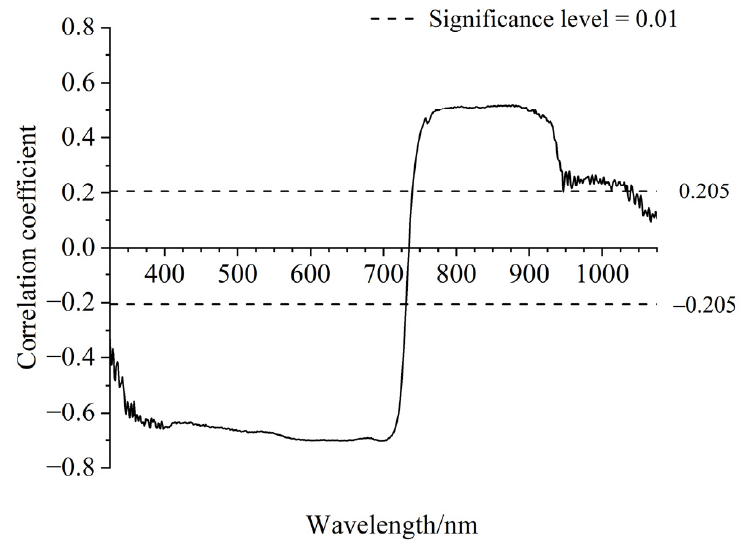
Figure 3. Correlation coefficients between reflectance and LAI (min/max, 0.34/5.56).3.3. Results of Different Models for LAI Prediction